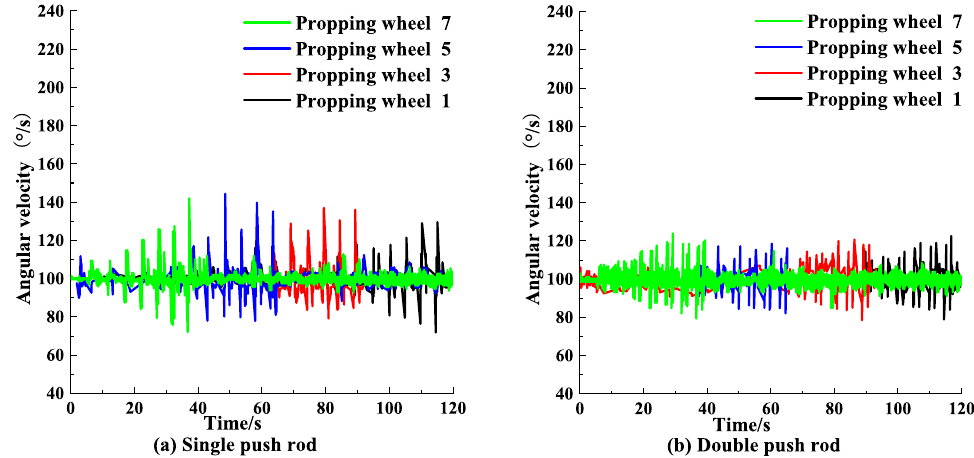
Figure 21. The change of the angular velocity of the support wheel of the single push rod support adjustment mechanism, double push rod − double spring support adjustment mechanism when crossing the casing reduction and casing